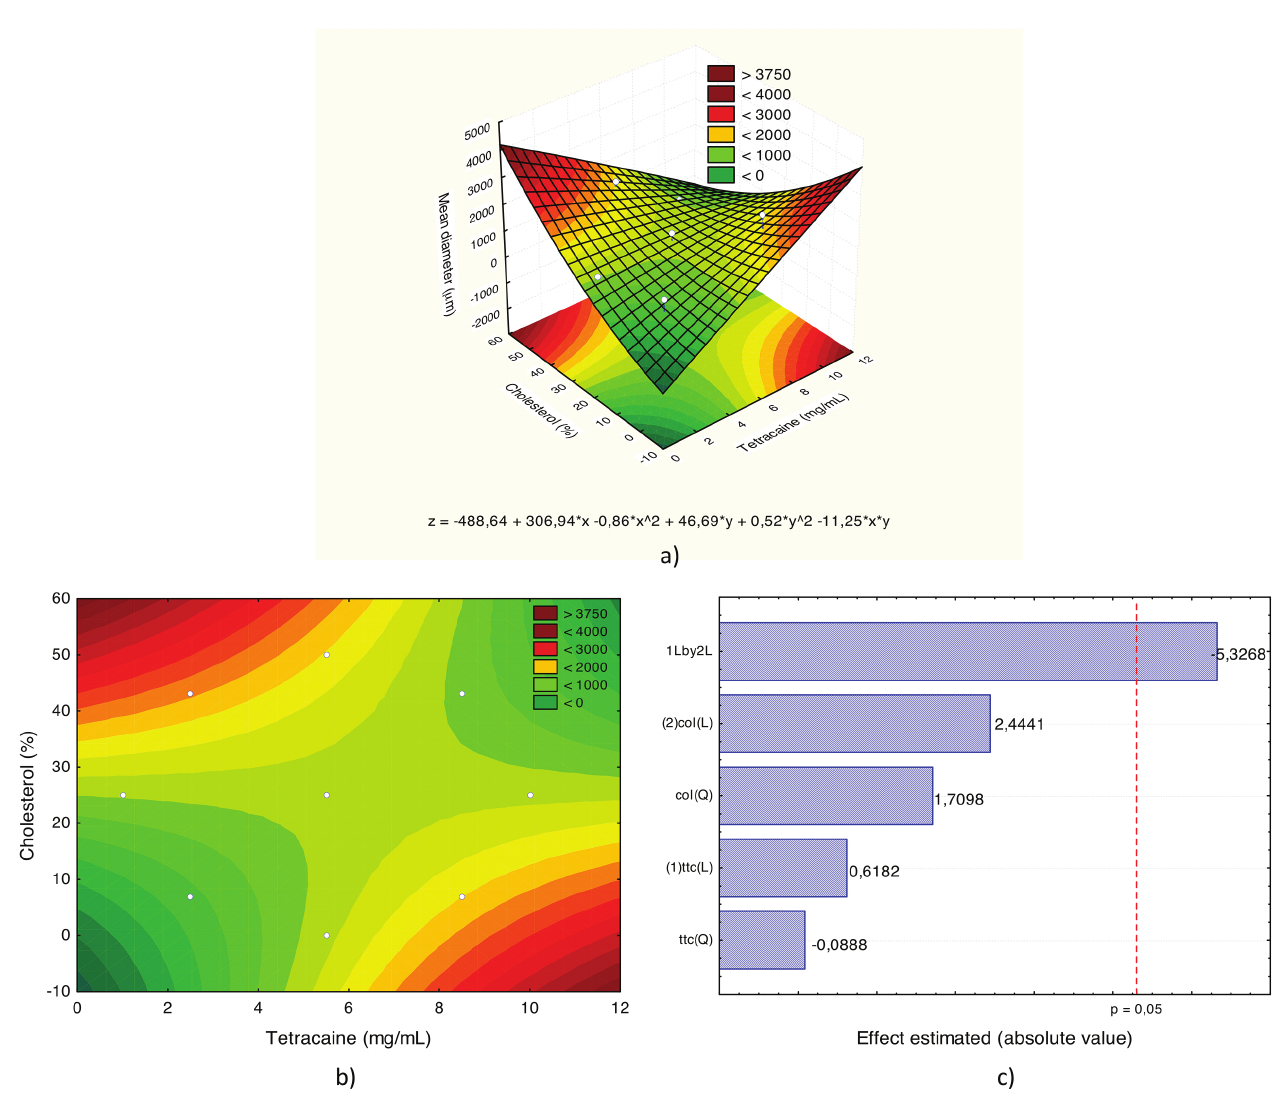
FIGURE 4 - Response surface (A), contour curve (B) and Pareto chart (C) for the mean diameter of liposomes prepared in the hydrophilic